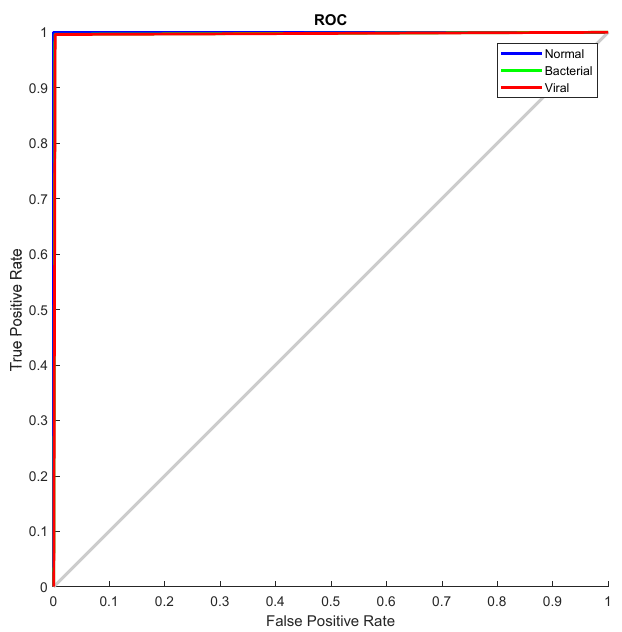
Figure 6. PneumoniaNet three classes confusion matrix.